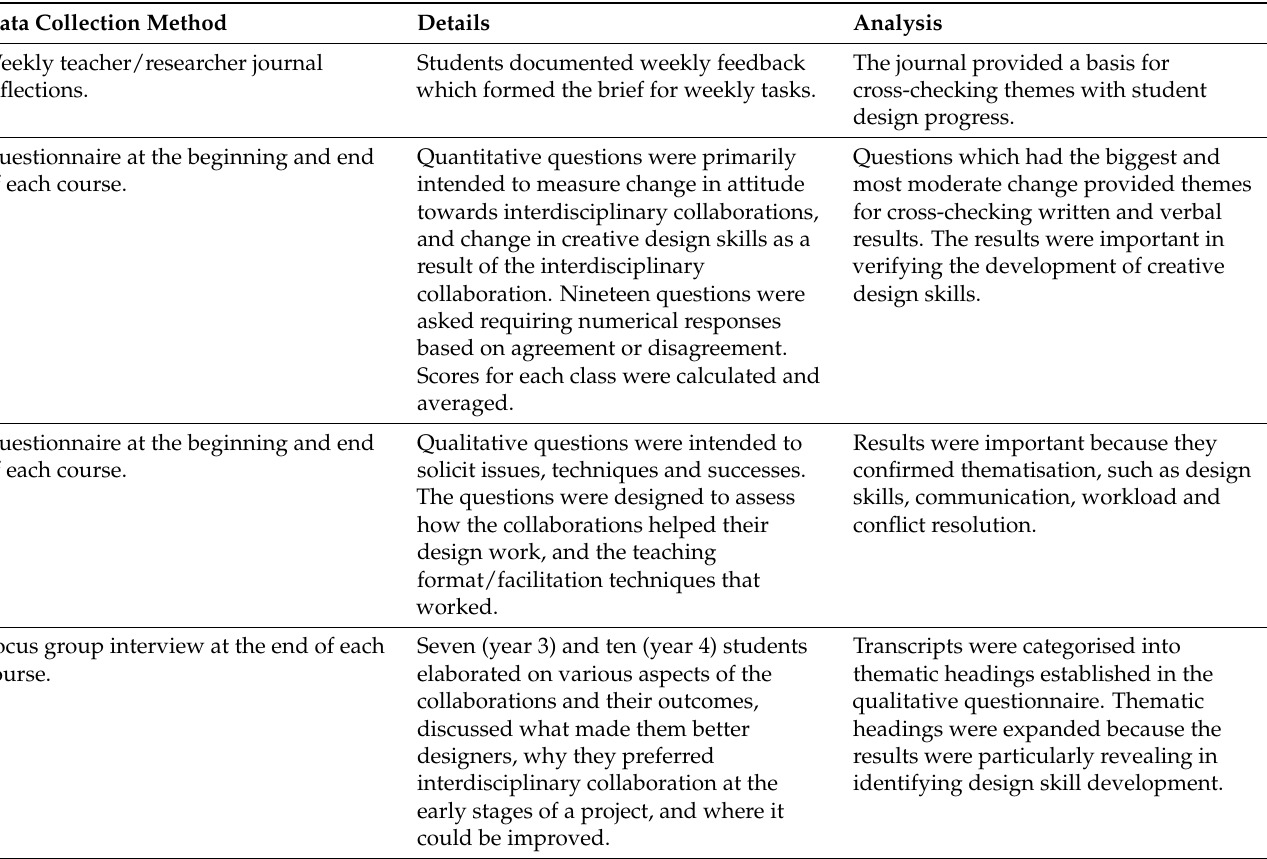
Table 1. Data collection